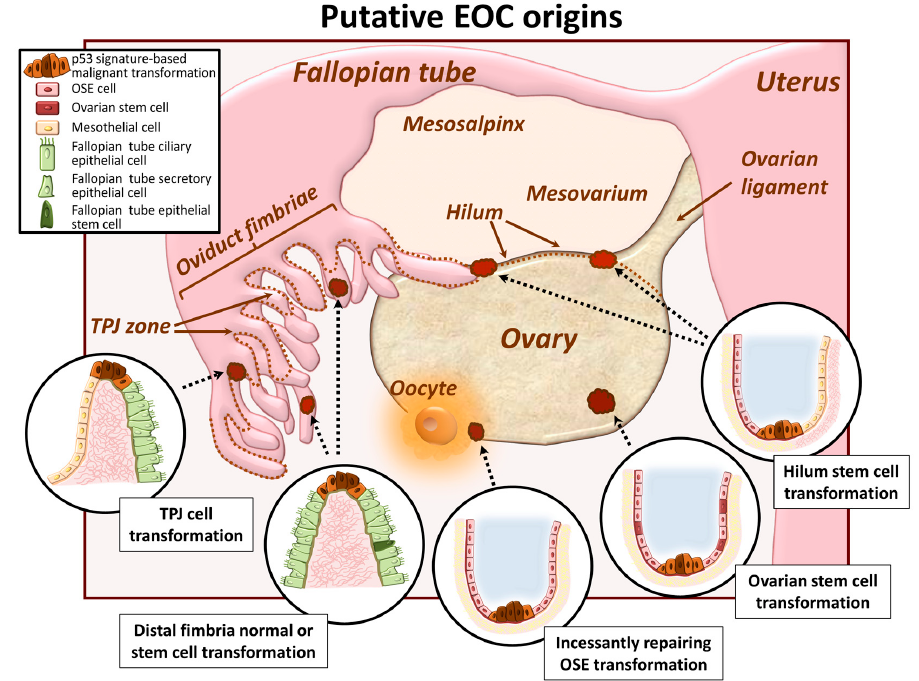
Figure 1. Putative epithelial ovarian cancer (EOC) origins. Represented is a schematic of the female reproductive system and the potential sites for ovarian cancer initiation. In the ovary, EOC may arise from the neoplastic conversion of the normal ovarian surface epithelium (OSE), as a result of frequent ovulatory rupture and post-ovulatory healing accompanied by transitions between mesenchymal and epithelial cell phenotypes; from malignantly transformed ovarian stem cells residing on the ovarian surface; or from the hilum, a translational zone between the ovary and mesothelium (and to some extent oviduct fimbriae), that contains cells with stem cell properties and propensity to tumorigenesis. In the fallopian tube, EOC may arise from the normal or stem-like cells in the distal fimbria actively participating in reproductive function-related fimbria injury; or from the tubal-peritoneal junction (TPJ), a region connecting mesothelium and oviductal fimbriae mucosa, often comprising translational metaplasia changes.